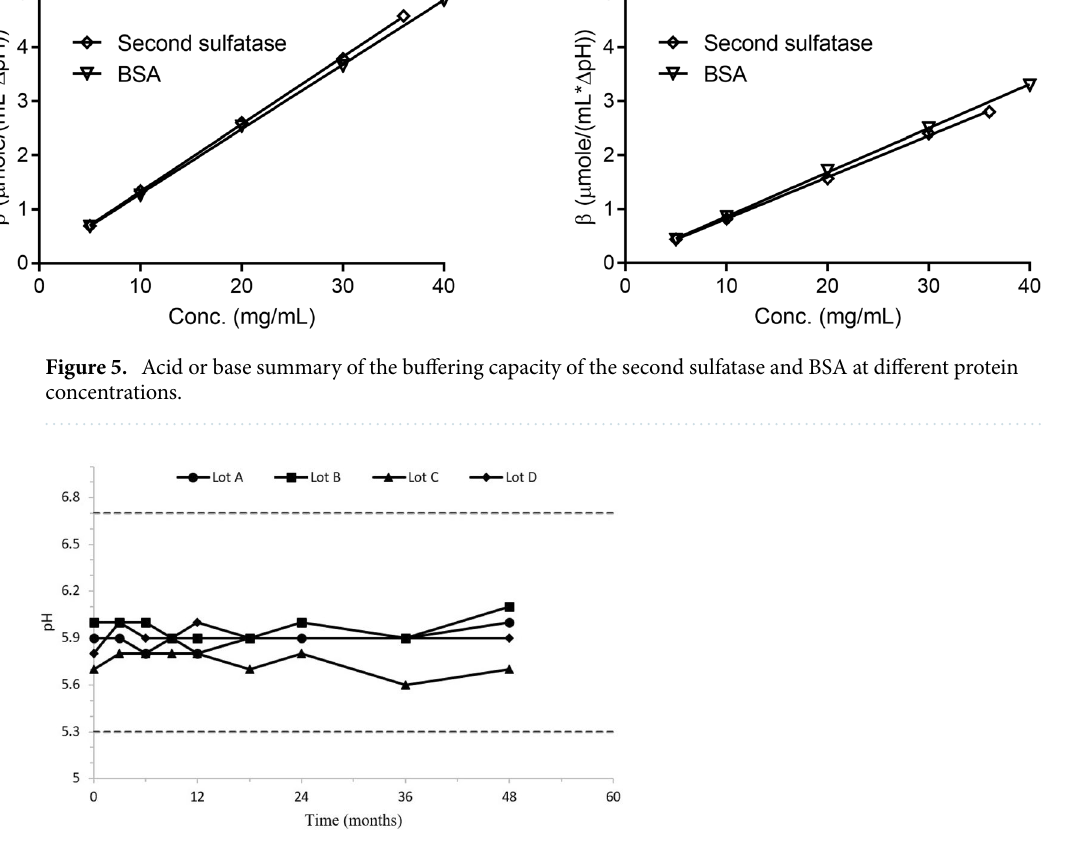
Figure 6. pH Values of four drug product lots of the target sulfatase as a function of time when stored for 48 months at long term storage condition of 5 ± 3 °C.